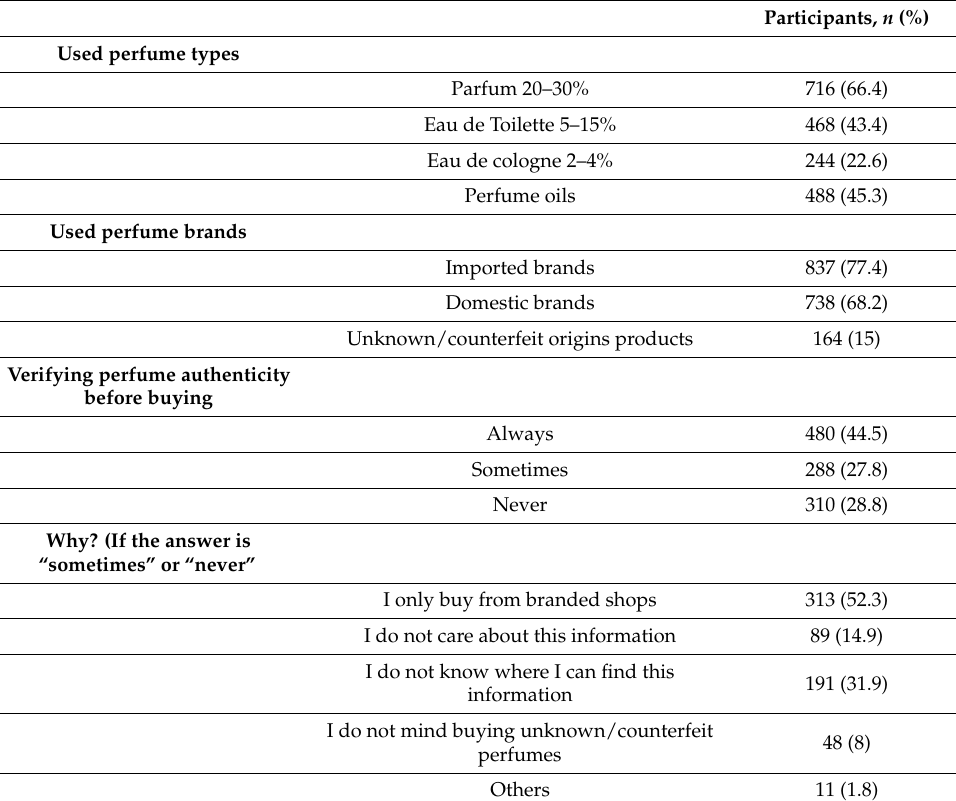
Figure 1. Perfume-buying sources among study participants ( n = 1078). Table 3. Perfume-buying behaviors among study participants ( n =